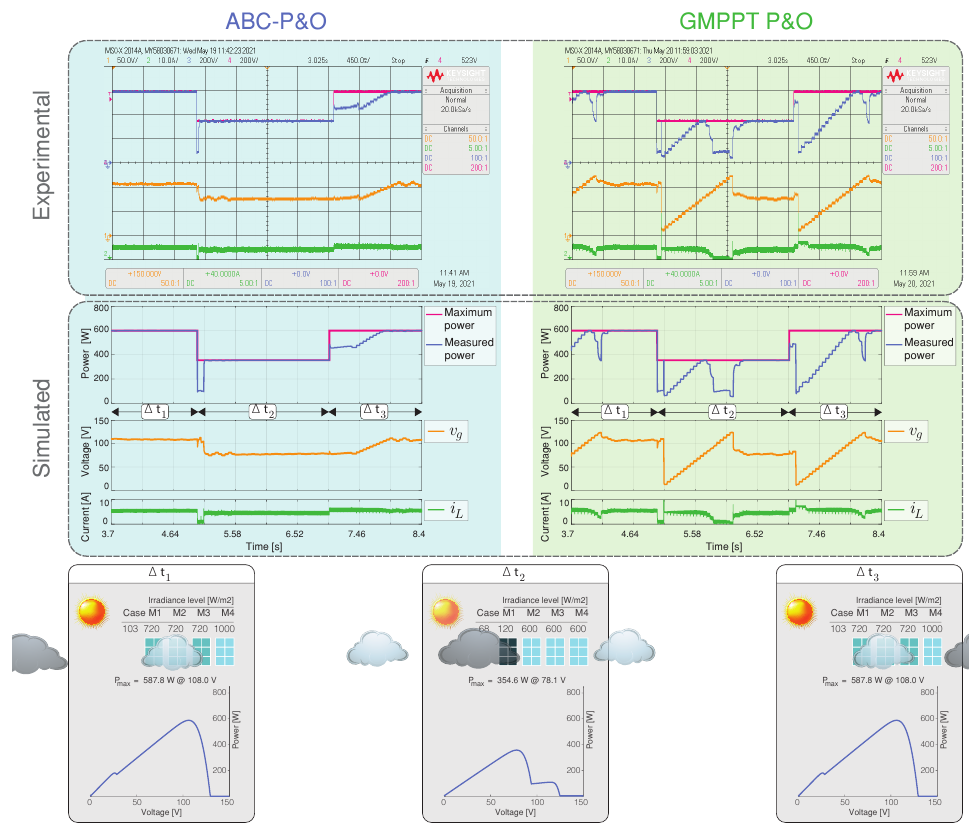
Figure 11. Simulated and experimental dynamic behavior of the MPPT algorithms for Scenario 3 with an output voltage V o = 160 V. The proposed MPPT algorithm (right) is compared with the GMPPT P&O algorithm (right). CH1: v g (50 V/div), CH2: i L (10 A/div), CH3: maximum power (200 W/div), CH4: measured power (200 W/div), and a time base of 450 ms. Consequently, the suggested GMPPT method had superior performance during abrupt irradia- tion variations compared to the GMPPT P&O method. Note that during the change from case 68 to 103, the ABC-P&O algorithm did not estimate an optimal reference voltage. Nonetheless, when P&O operated, GMPPT was achieved, demonstrating the robustness of the ABC-P&O